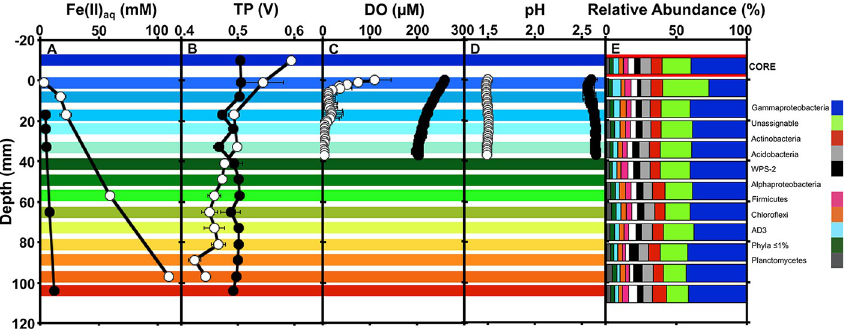
Fig 2. Depth profiles of dissolved Fe(II) (Fe(II) aq ; A), total potential (TP; B), dissolved oxygen concentrations (DO; C), pH (D), and phylum-level microbial community composition (E) at the conclusion of non-sterile ( � ) and formaldehyde-deactivated (•) column incubations that were incubated under continuously oxic conditions. The colored shading across panels A-D indicates depth intervals corresponding to data points shown in Fig 1, and the color key for panel E is shown on the left side of the figure. The bar outlined in red in panel E represents the composition of the core microbiome of the entire column. Error bars represent one standard deviation.